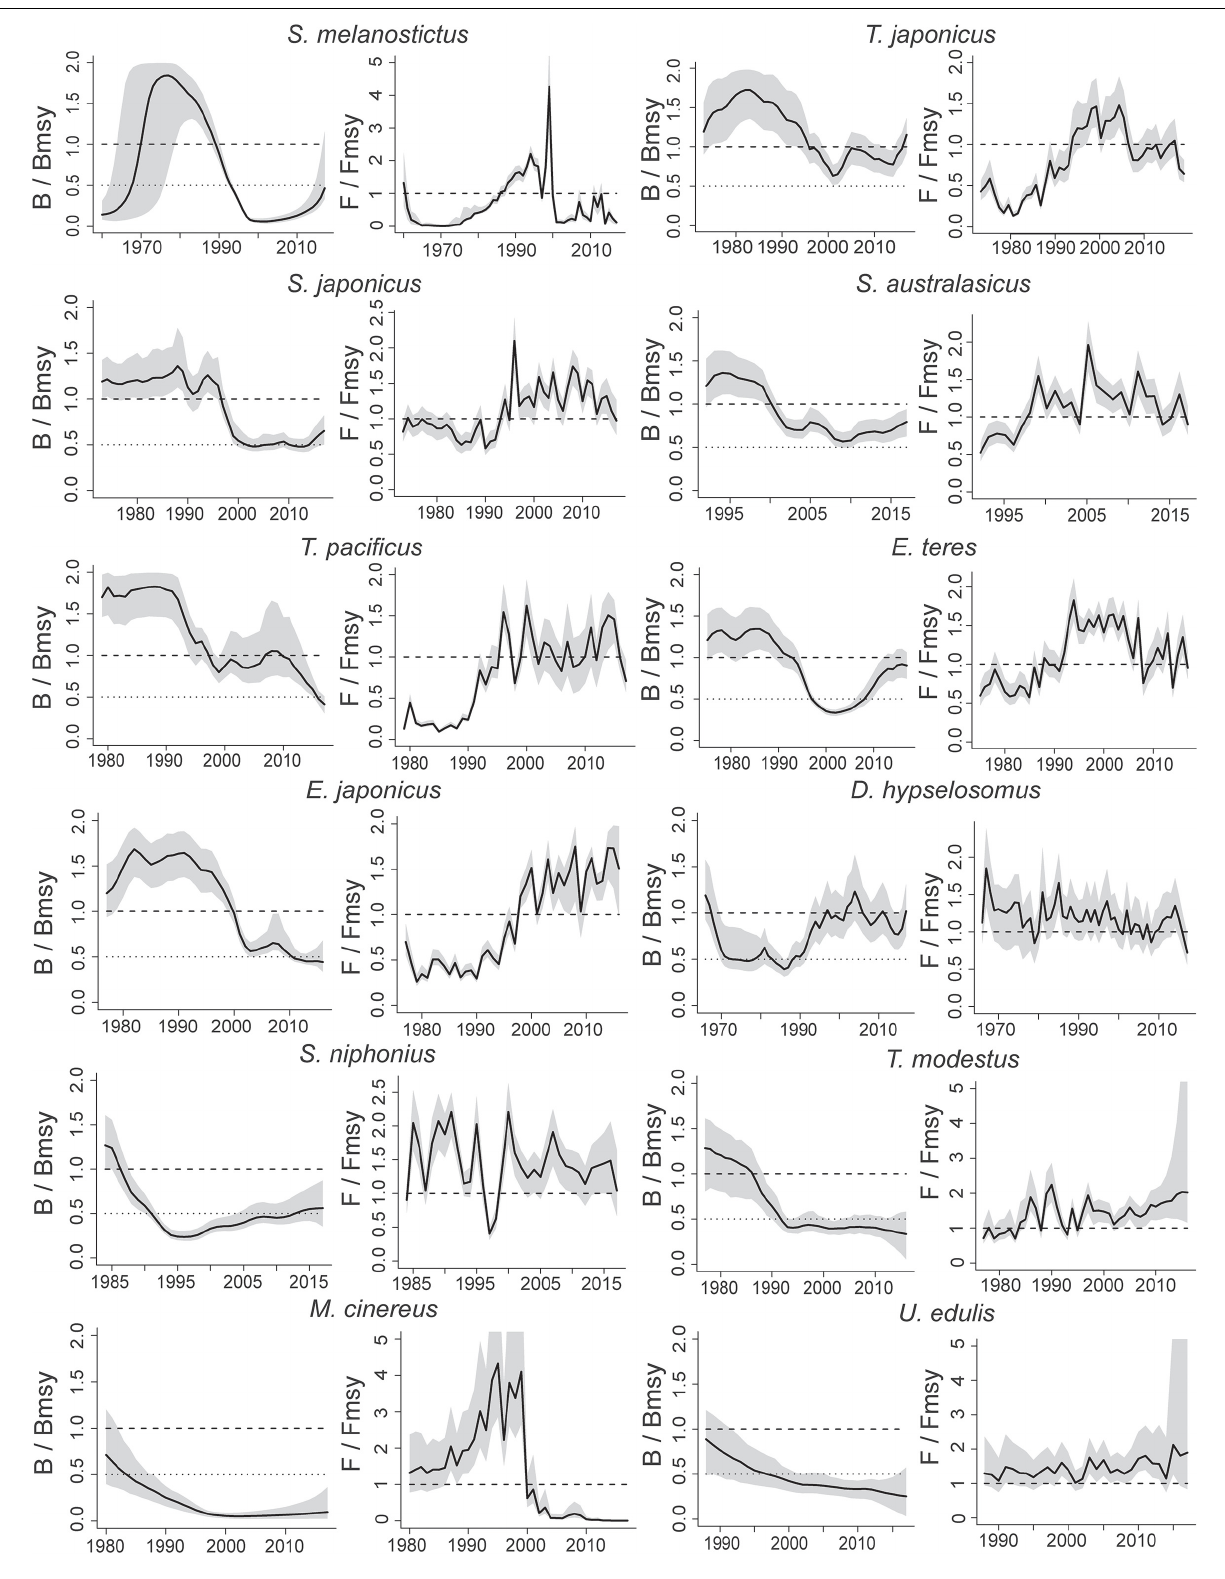
Frontiers in Marine Science |